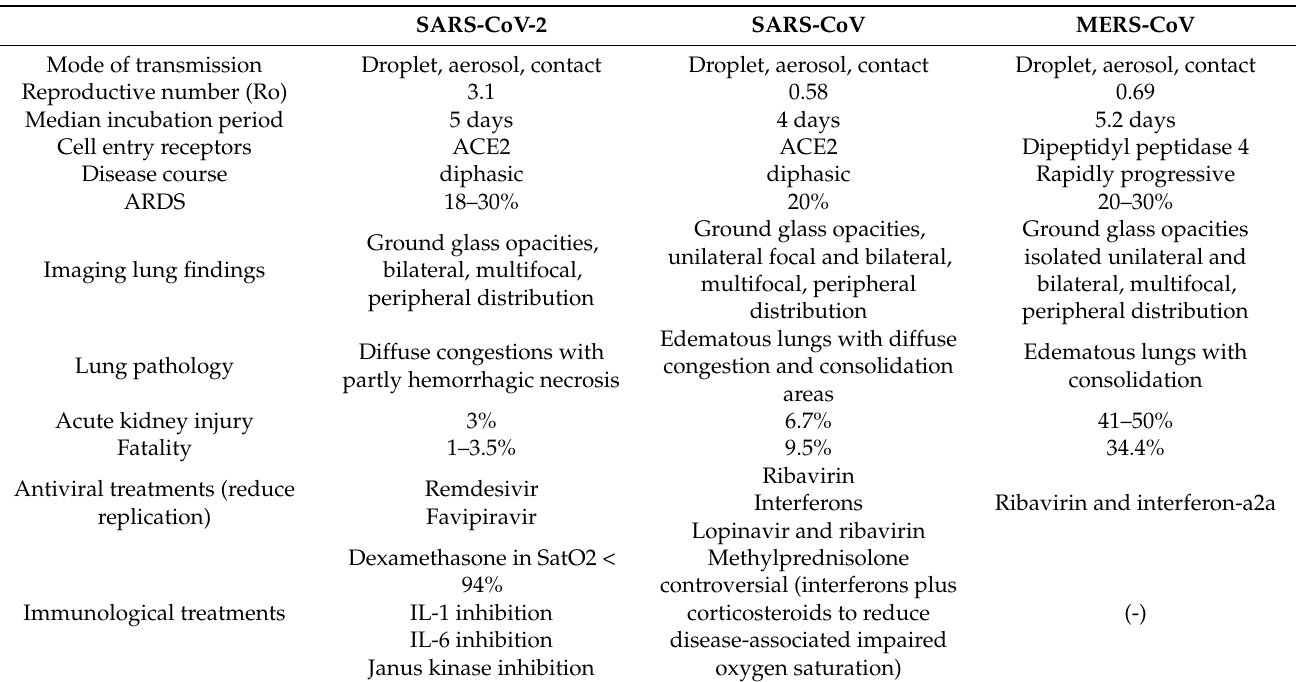
Table 1. Characteristics, similarities and differences among three coronaviruses